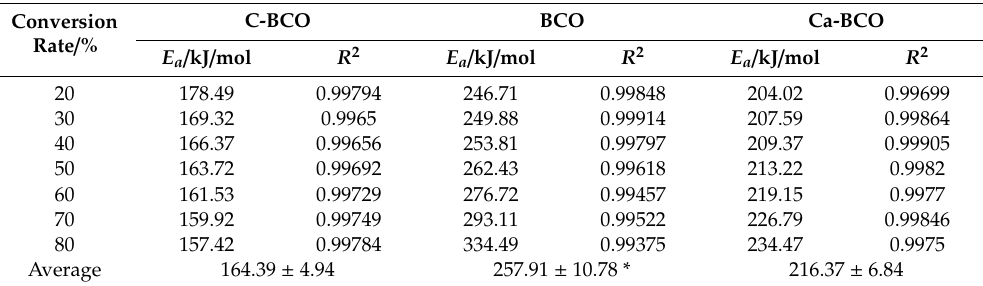
Figure 5. Plots of ln( β / T 2 ) versus 1000 / T at various conversions of the main mass loss zone for C-BCO ( a ), as-prepared BCO nanowires ( b ), and Ca-BCO nanowires ( c ) based on the Kissinger–Akahira–Sunose method. Table 3. Apparent activation energy of nanostructured (BiO) 2 CO 3 samples calculated by Kissinger– Akahira–Sunose’s methods in a range of α =